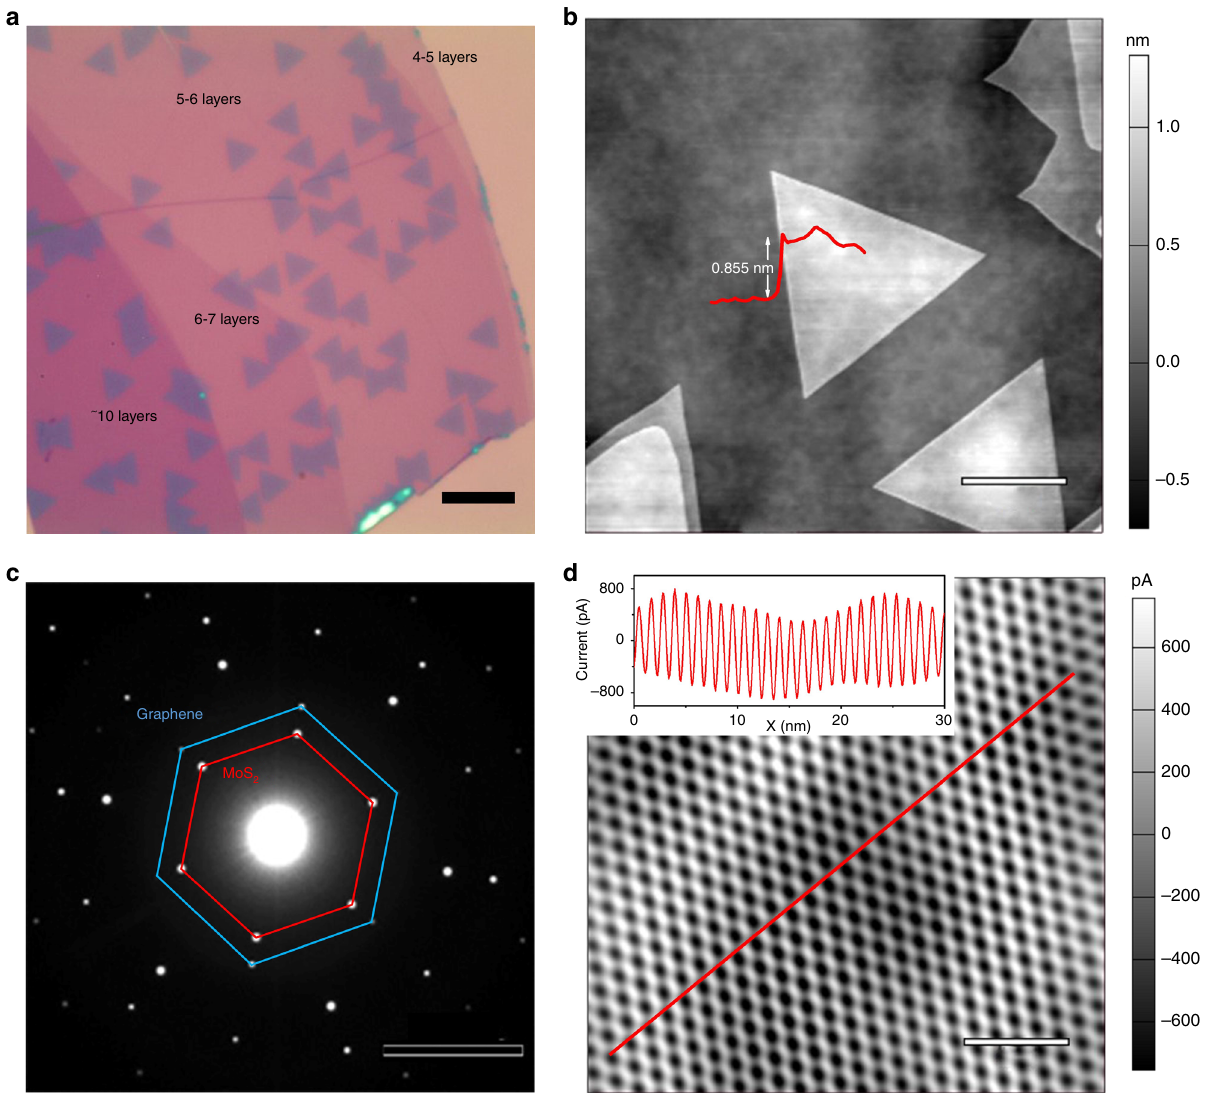
Fig. 1 Structures of MoS 2 /Gr heterojunctions. a Optical image of as-grown MoS 2 triangle domains on graphene, scale bar, 10 μ m. b AFM image, scale bar, 2 μ m. c SAED pattern of a typical MoS 2 /Gr heterojunction, scale bar, 5 nm − 1 . d C-AFM imaging of the moiré superlattice of MoS 2 /Gr after Fast Fourier Transform fi lter, scale bar, 5 nm. The period of superlattice is ∼ 1.18 nm as shown in the